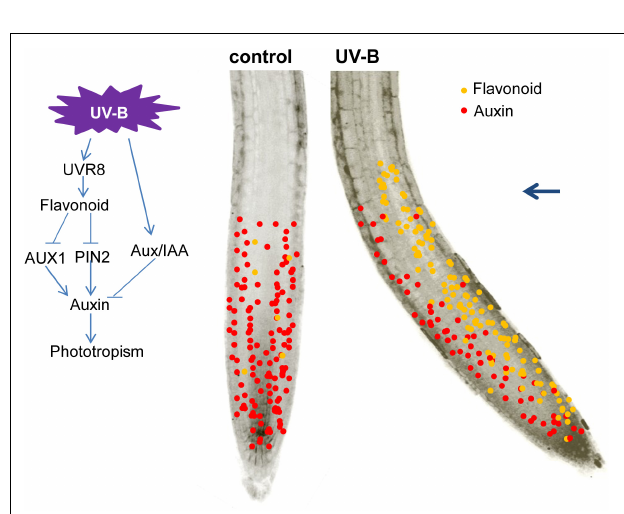
FIGURE 9 | A proposed model of UV-B-mediated root bending. Blue arrow indicates the direction of UV-B